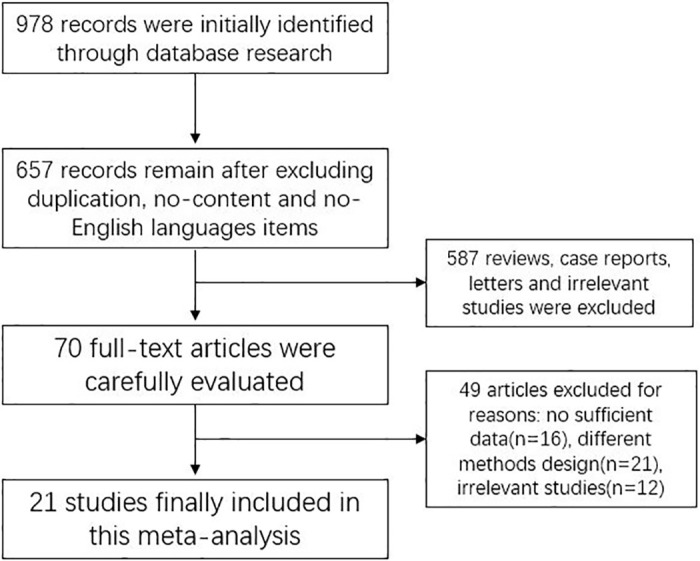
Flow chart of the selection process in this meta-analysis.